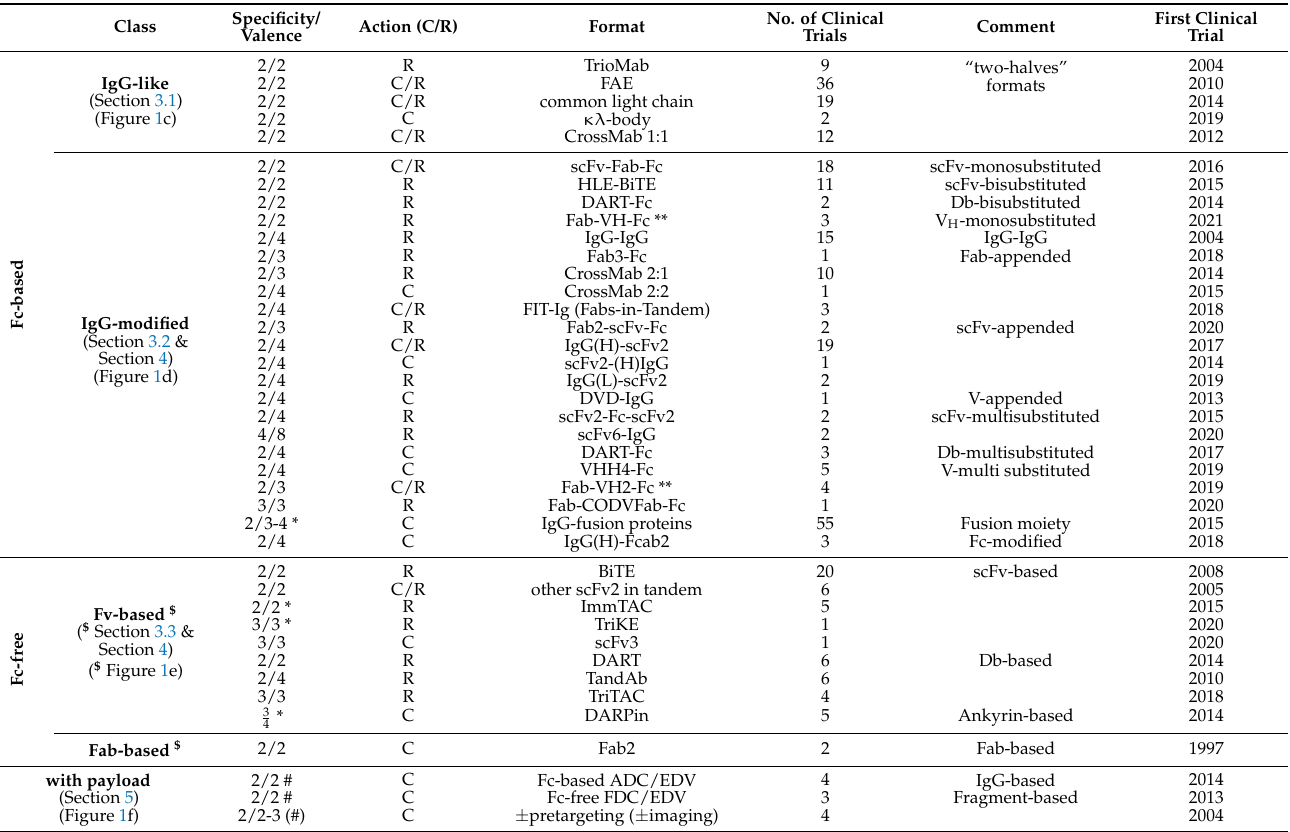
Table 1. Multispecific antibody formats in clinical trials by structure, mode of action and start year of first study.